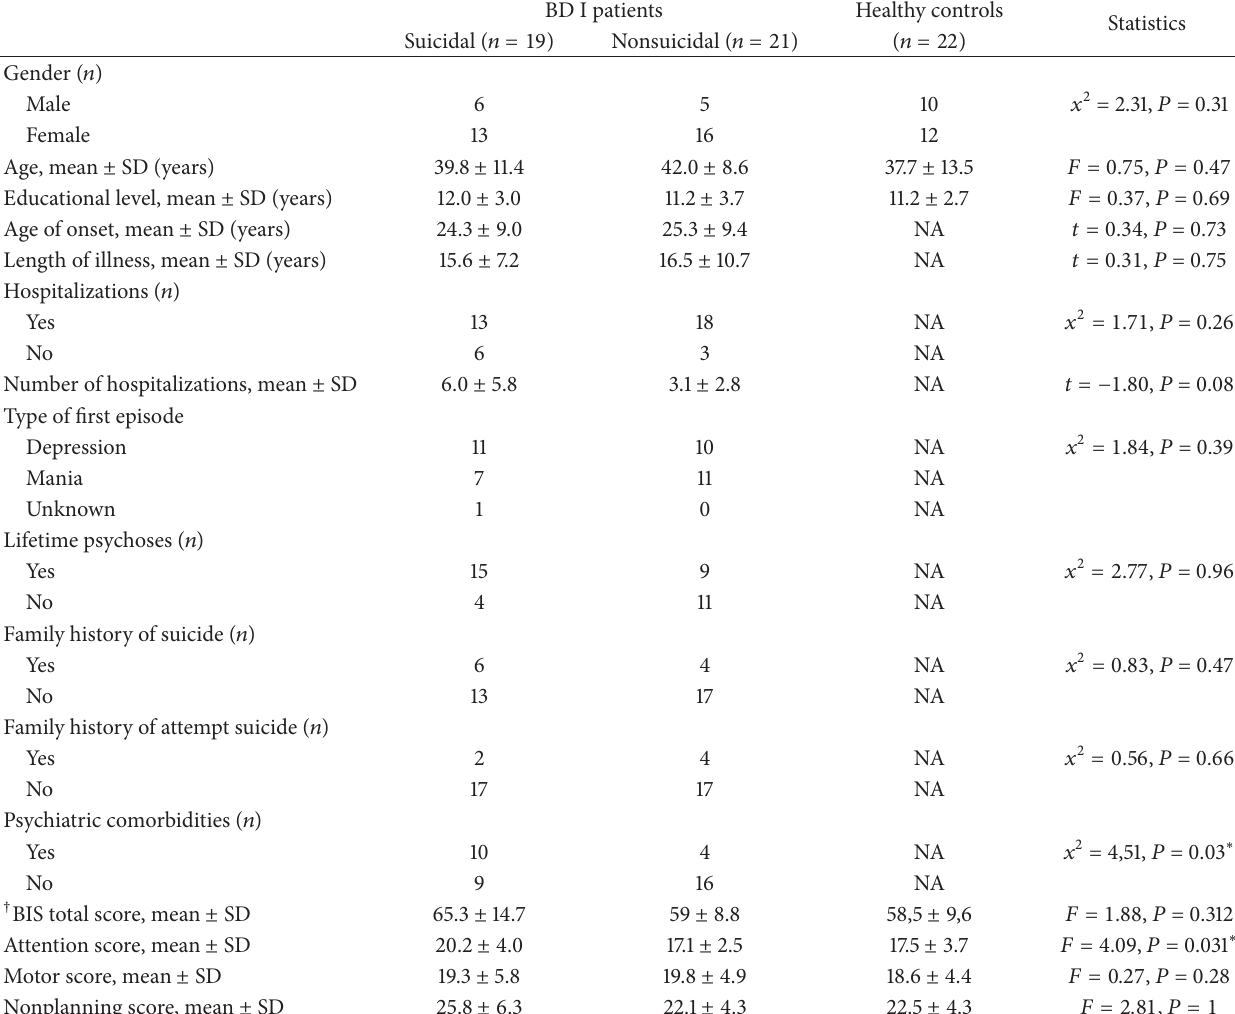
Table 1: Demographic and clinical data of the